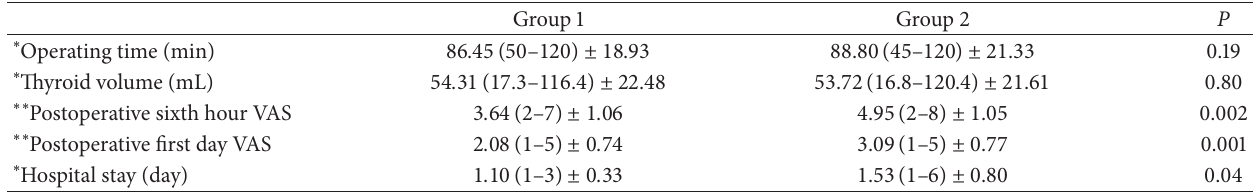
Table 2: Operative and postoperative values of the